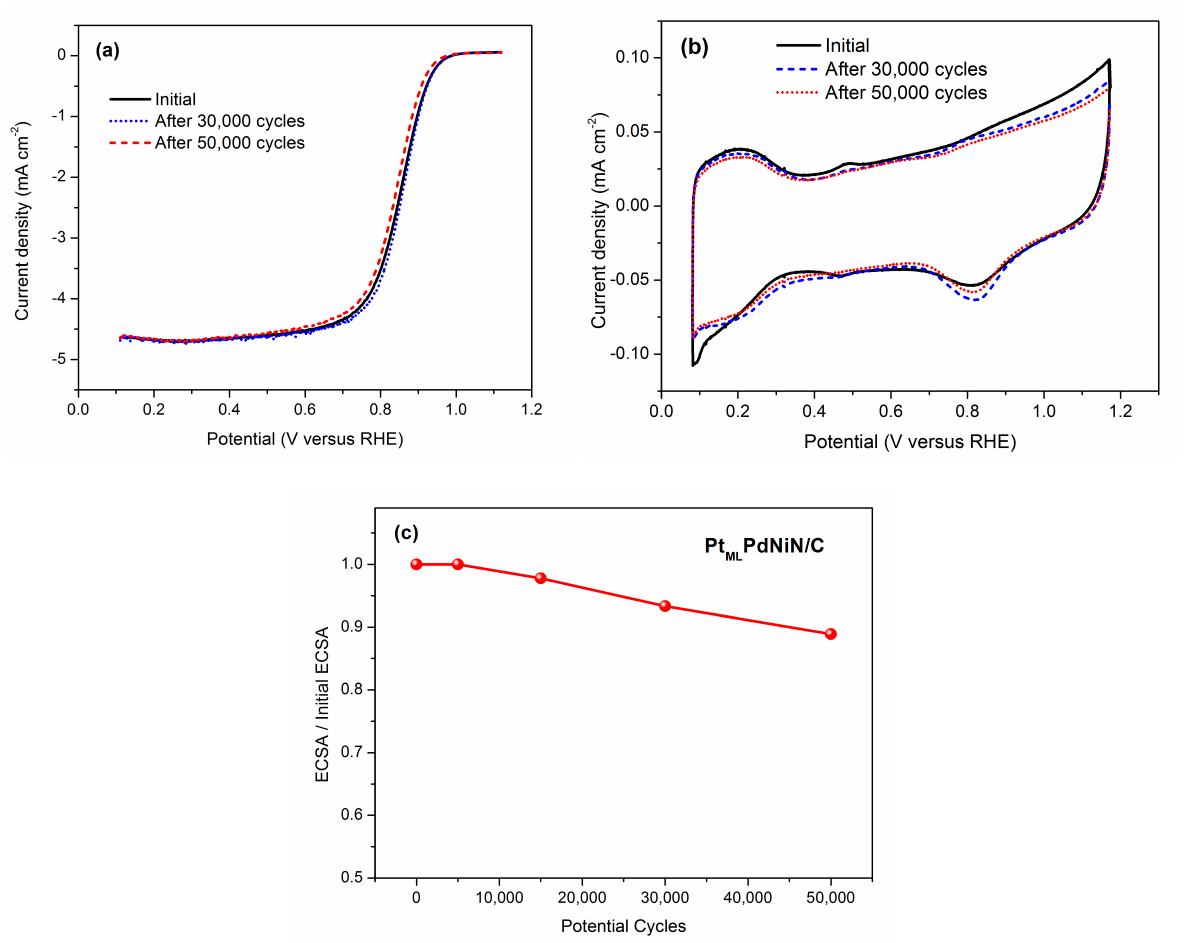
Figure 5. ( a ) ORR polarization curves and ( b ) cyclic voltammograms of the obtained Pt ML PdNiN/C catalyst before and after 50,000 cycles test between 0.6 and 1.0 V in 0.1 M HClO 4 solution; ( c ) ECSA degradation for Pt ML PdNiN/C catalyst plotted as a function of the number of after potential cycles between 0.6 and 1.0